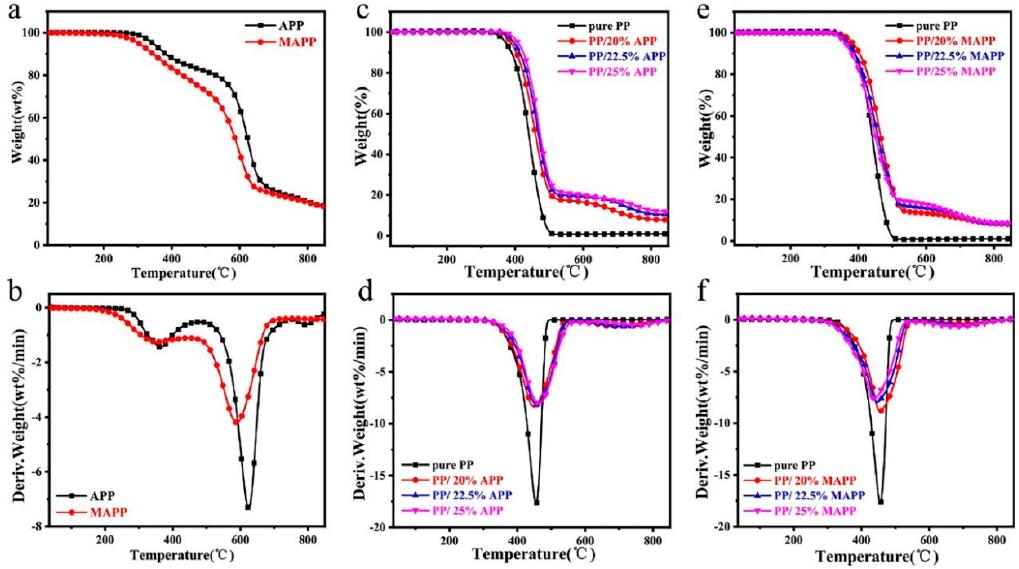
Figure 5. ( a ) TG and ( b ) DTG curves of APP and MAPP. ( c , e ) TG and ( d , f ) DTG curves of PP and its flame-retardant blends under the nitrogen atmosphere. Table 3. TGA data of the IFR-PP samples under nitrogen atmosphere.